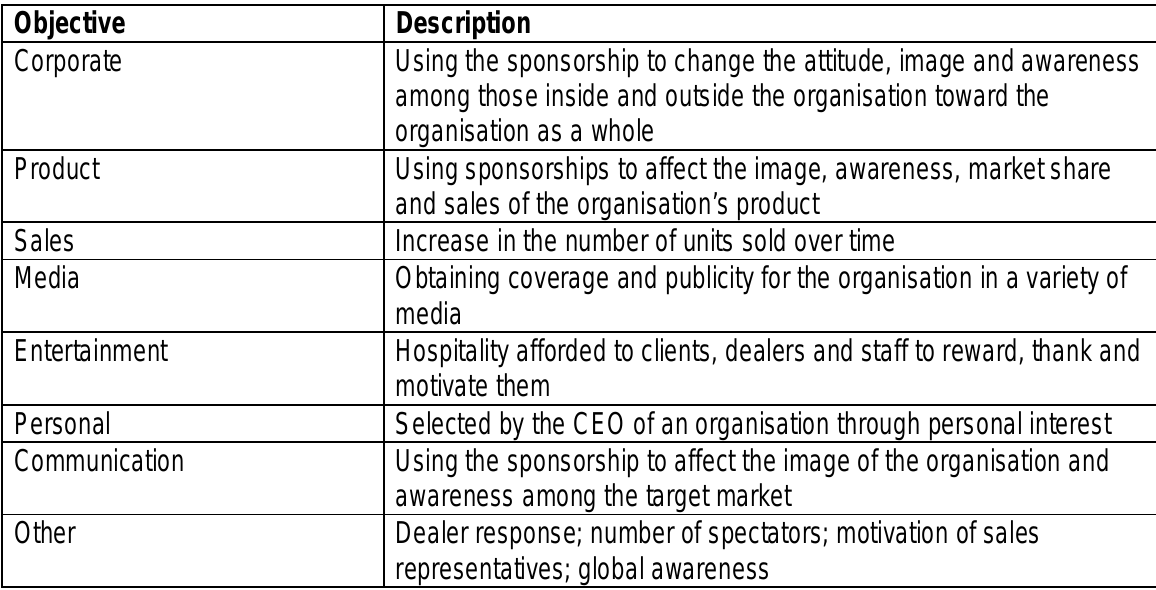
Table 1: A summary of the main sponsorship objectives